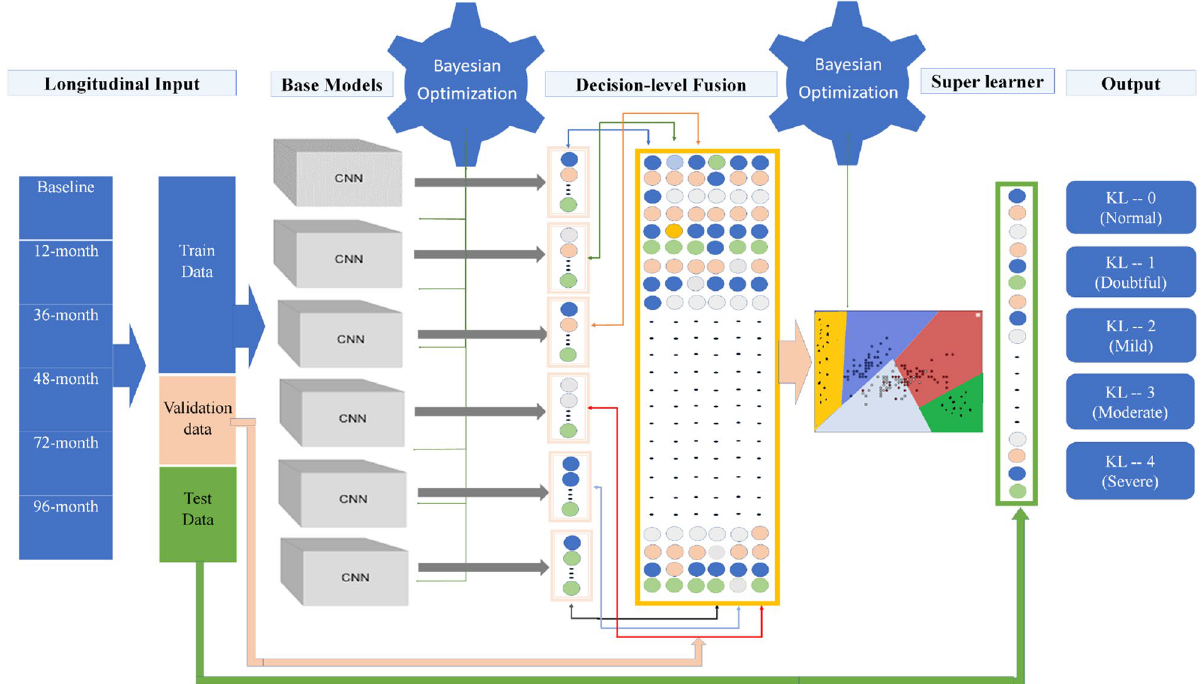
Figure 7. The network architecture for classification